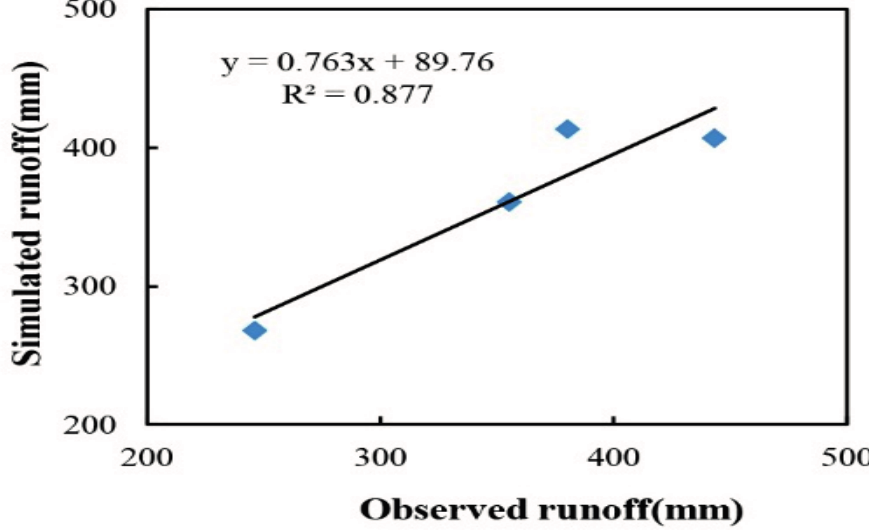
Figure 4. Comparison between observed and simulated runoff at the annual scale for the validation process.